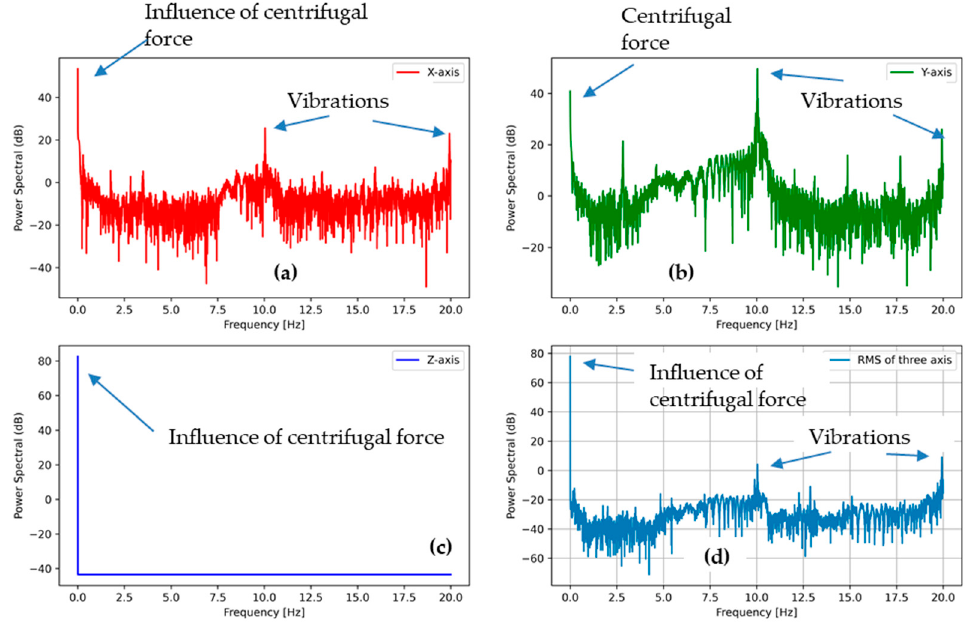
Figure 14. PSD of the accelerometer outputs from the tumble phase (600 RPM) (after removing initial acceleration phase) ( a ) in the X direction, ( b ) in the Y direction, and ( c ) in the Z direction, ( d ) the sum of all the accelerations.